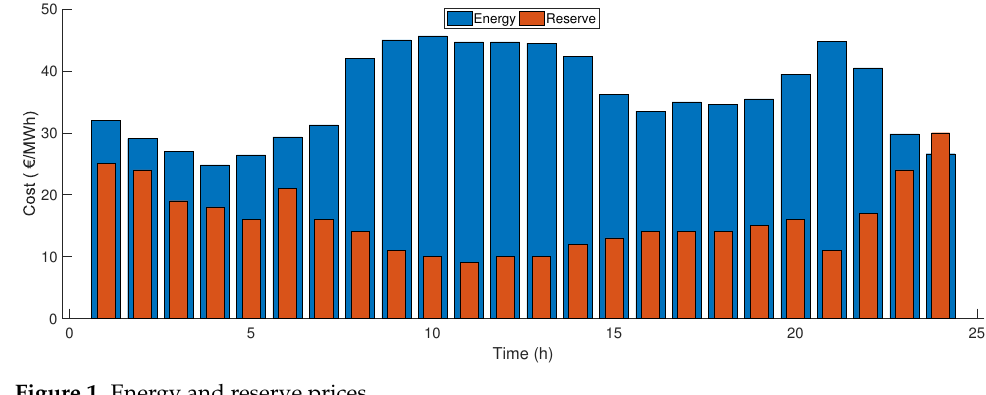
Figure 1. Energy and reserve prices.